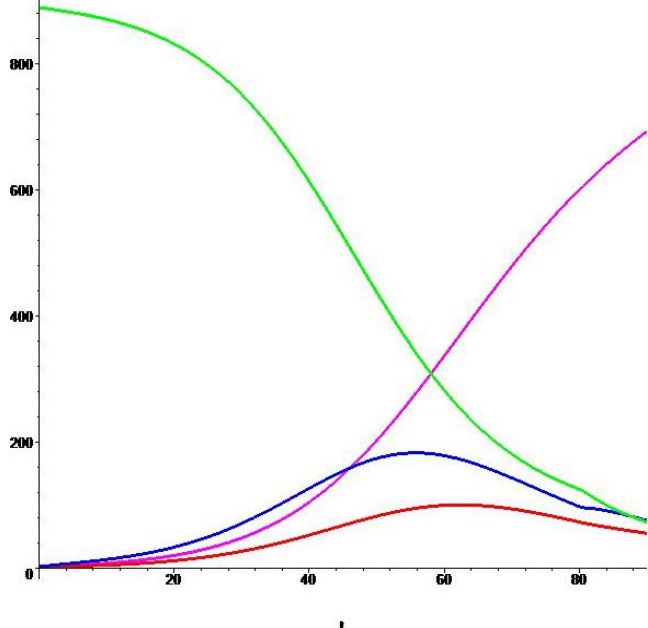
( t ) , E ( t ) , I ( t ) , R ( t ) for the Ebola outbreak ∗ ∗ ∗ ∗